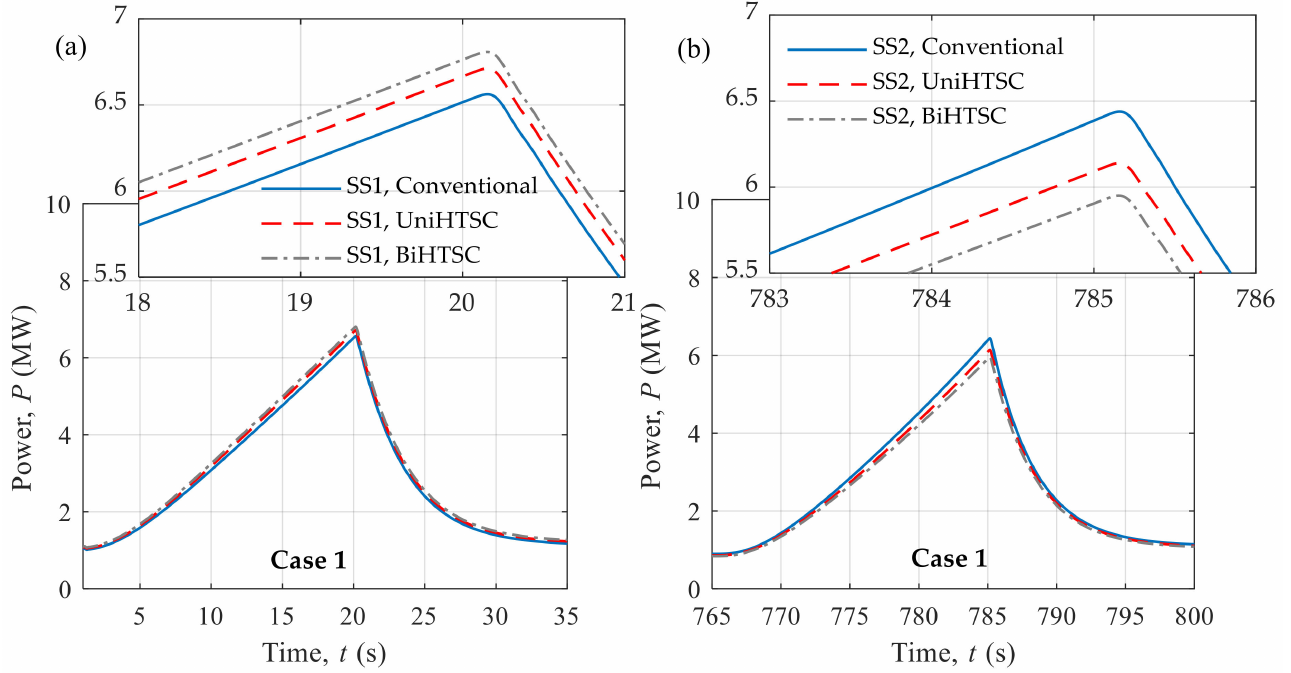
Figure 19. Peak instantaneous power supplied by the two substations for the three cable technologies in scenario 1: ( a ) SS1 at t = [0 s, 35 s], ( b ) SS2 at t = [765 s, 800